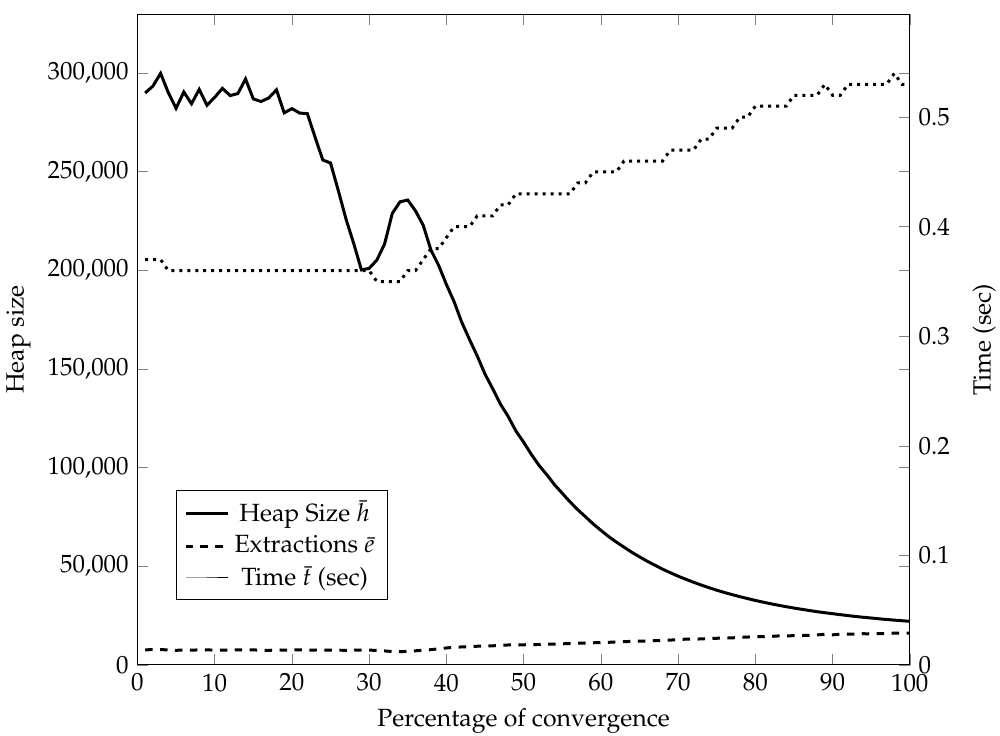
Figure 3. Uniform (UNI) n = 1600, averages on 100 convergences, each of 100 steps (obtained by normalizing convergences of different